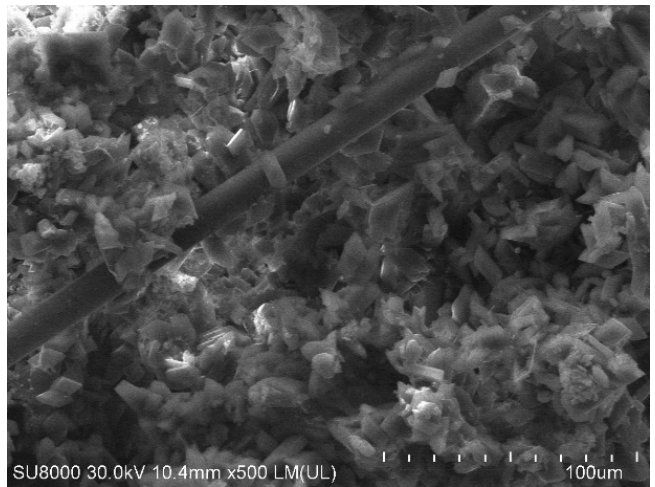
Figure 6. SEM image of gypsum plasters containing 0.5 wt.% of glass fiber.